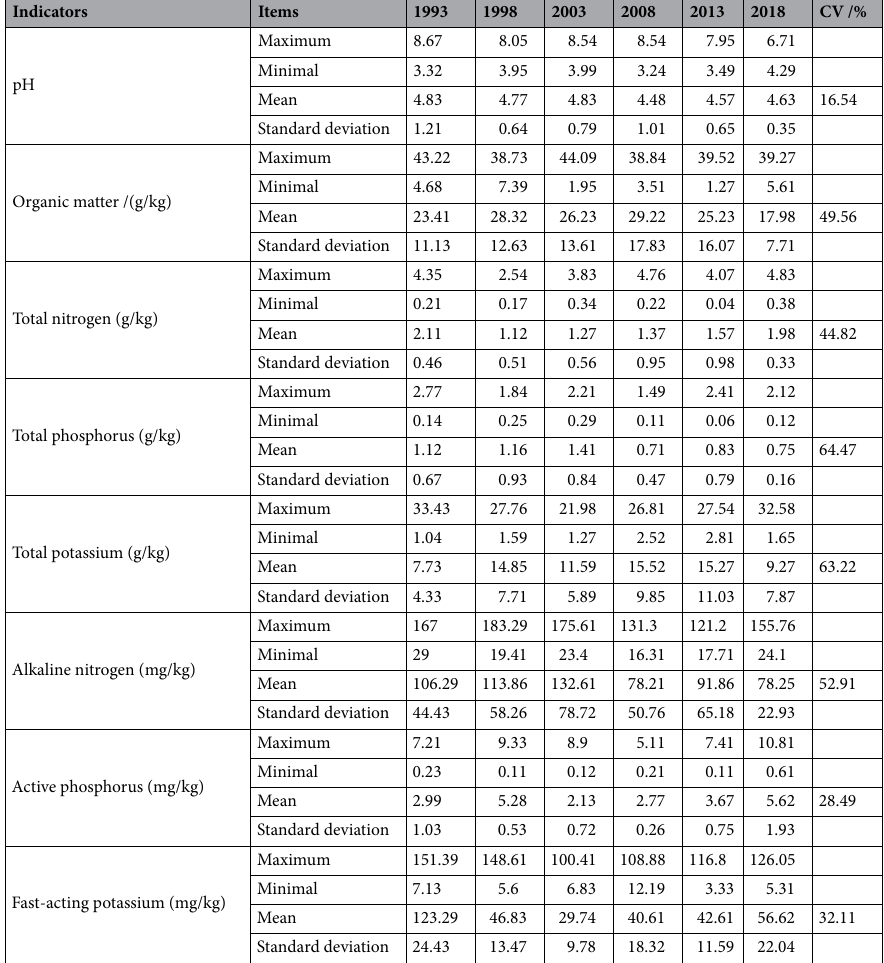
Table 6. Evolutionary characteristics of soil chemical indicators in eucalyptus plantation forests. “CV” refer to Coefficient of variation.